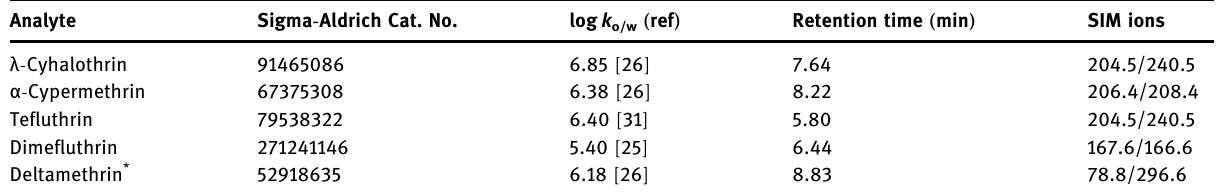
Table 1: Octanol – water partition coe ffi cients, retention times, and selected SIM ions for pesticides studied Analyte Sigma - Aldrich Cat.